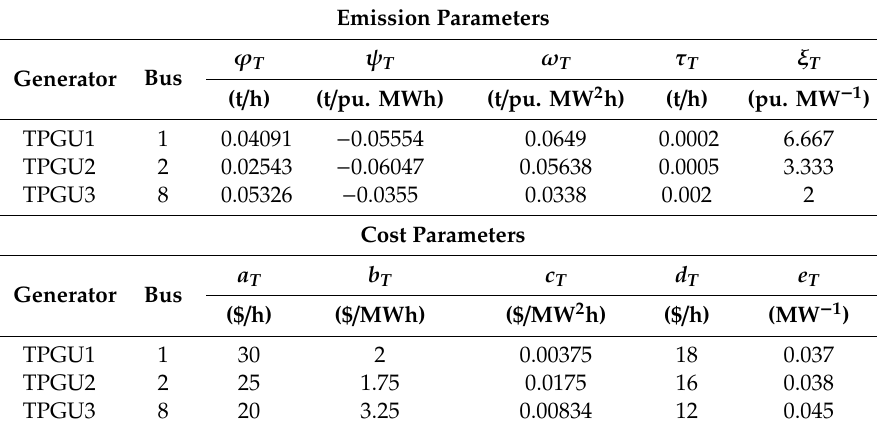
Figure 3. Fuel cost function with and without the impact of valve point. Table 4. Emission and cost parameters of the TPGUs [30].